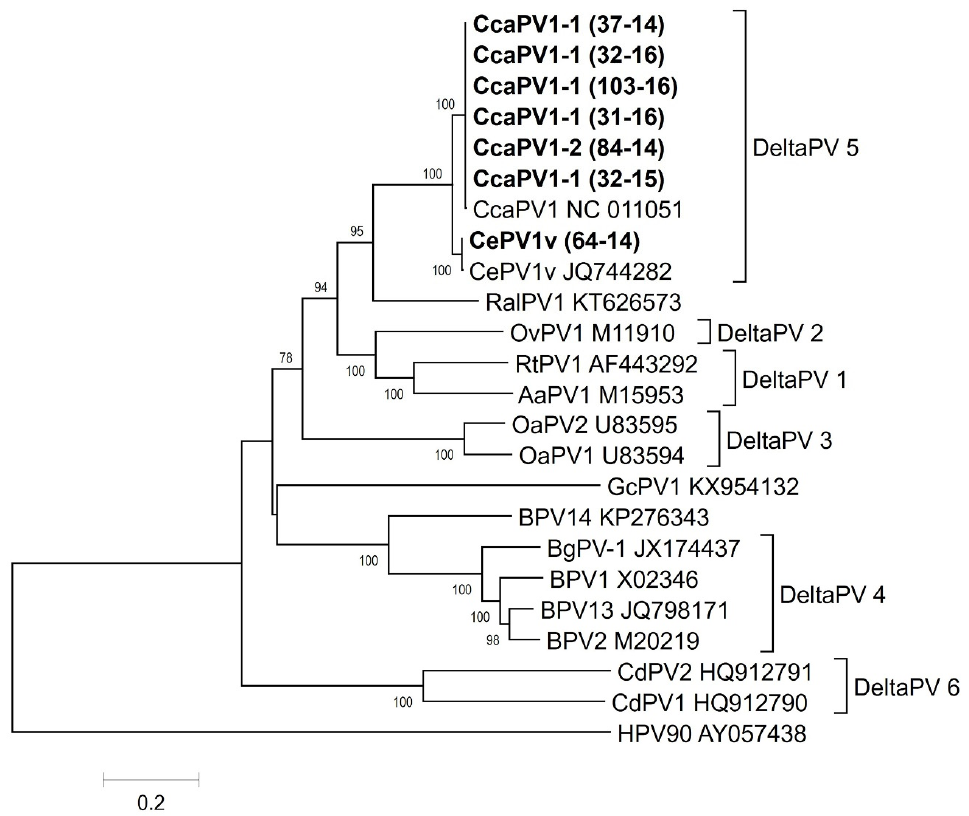
Figure 4. Neighbor-Joining (NJ) phylogenetic tree with the (T92+G) substitution model of the concatenated E1 , E2 , L1 and L2 gene sequences. Statistical support for the phylogenetic tree was evaluated via bootstrapping based on 1000 repetitions. Bootstrap values lower than 70 are not shown. The Slovenian PV strains are indicated in bold.